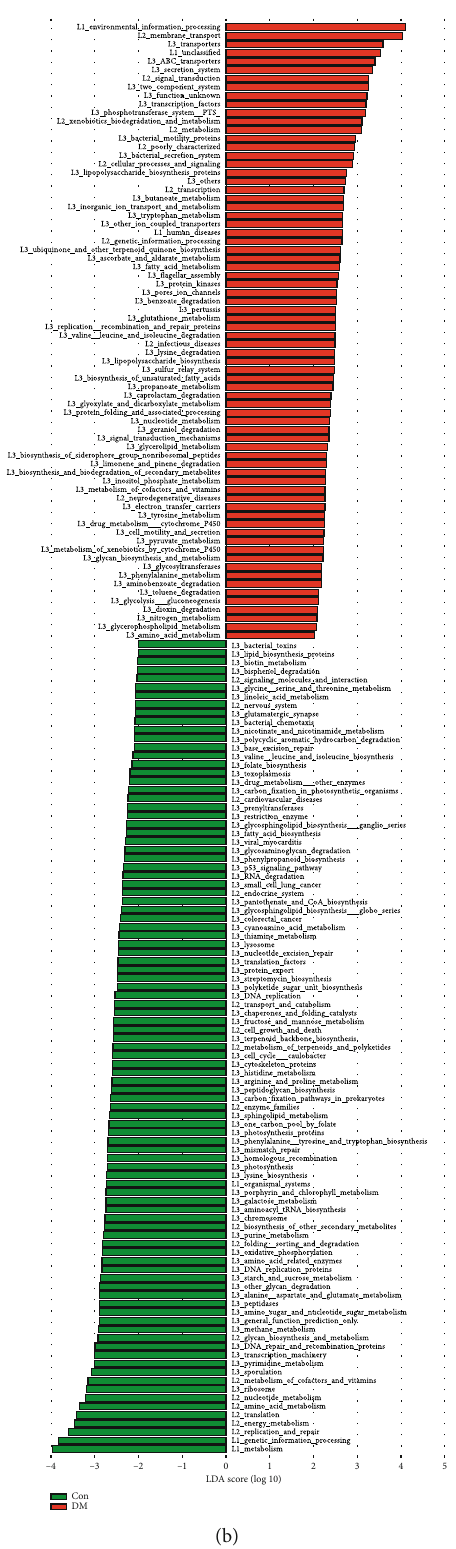
Figure 4: Predicted KEGG pathways. (a) LEfSe analysis showing di ff erent metabolic pathways between DM and Con. (b) LEfSe analysis showing di ff erent metabolic enzymes between DM and Con. KEGG: Kyoto Encyclopedia of Genes and Genomes; LEfSe: linear discriminate analysis and e ff ect